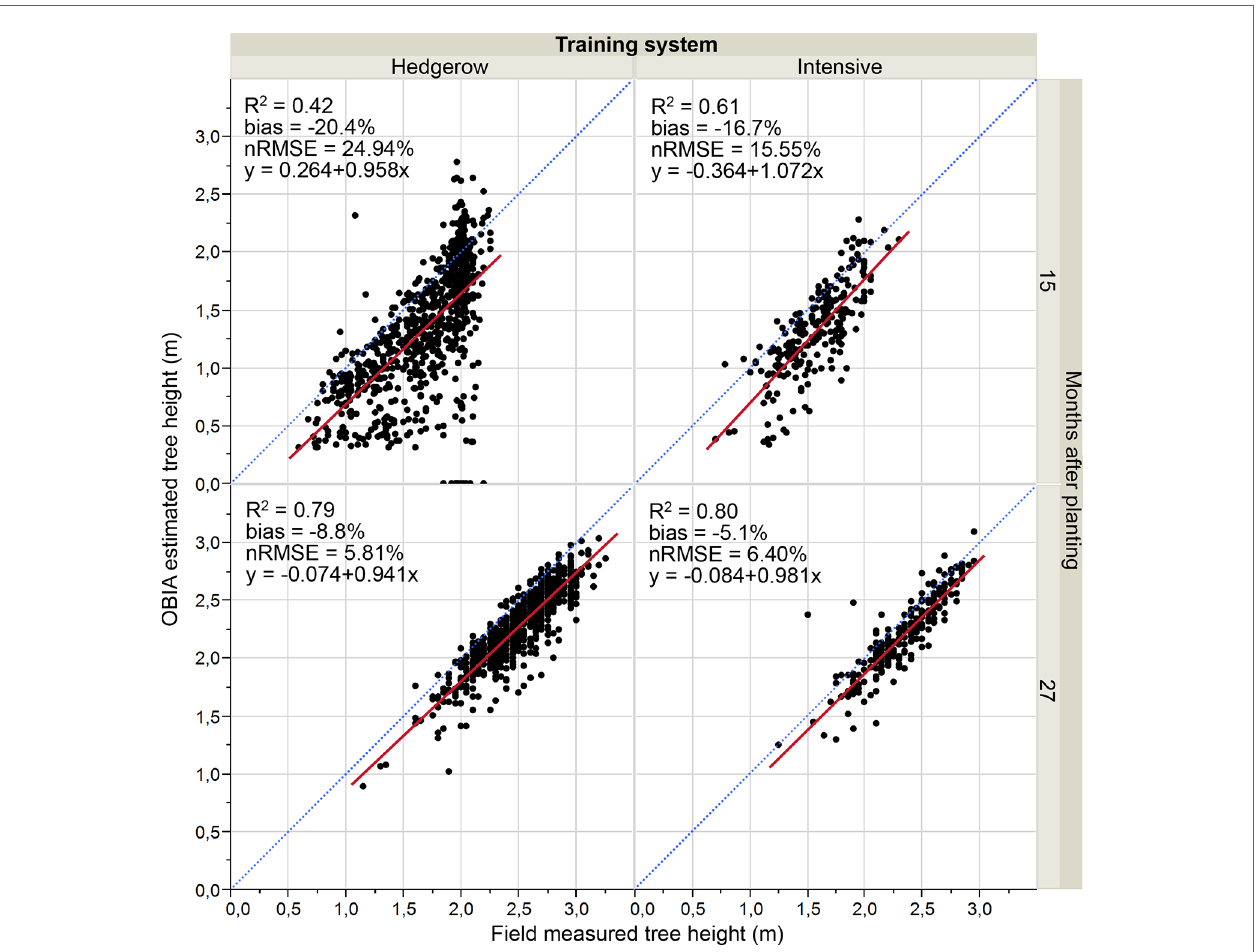
FIgUrE 7 | Point cloud-OBIA estimated height vs. measured olive height divided by training system and tree age. The relative root mean square error (nRMSE) and coefficient of determination (R 2 ) derived from the regression fit are included for every scenario (p 0.0001). The red solid line is the fitted linear function and the blue dashed line represents the 1:1